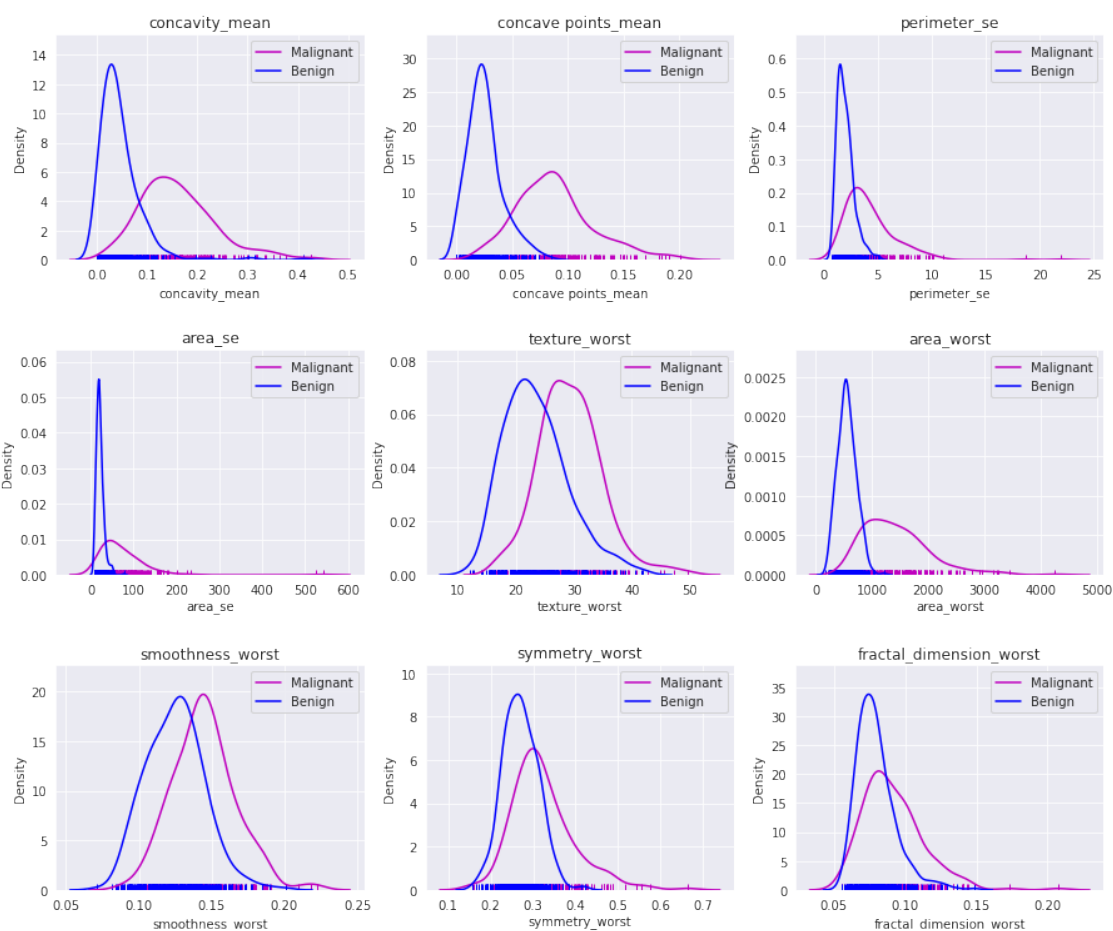
Figure 6. Distribution of malignant and benign cells for reduced features for